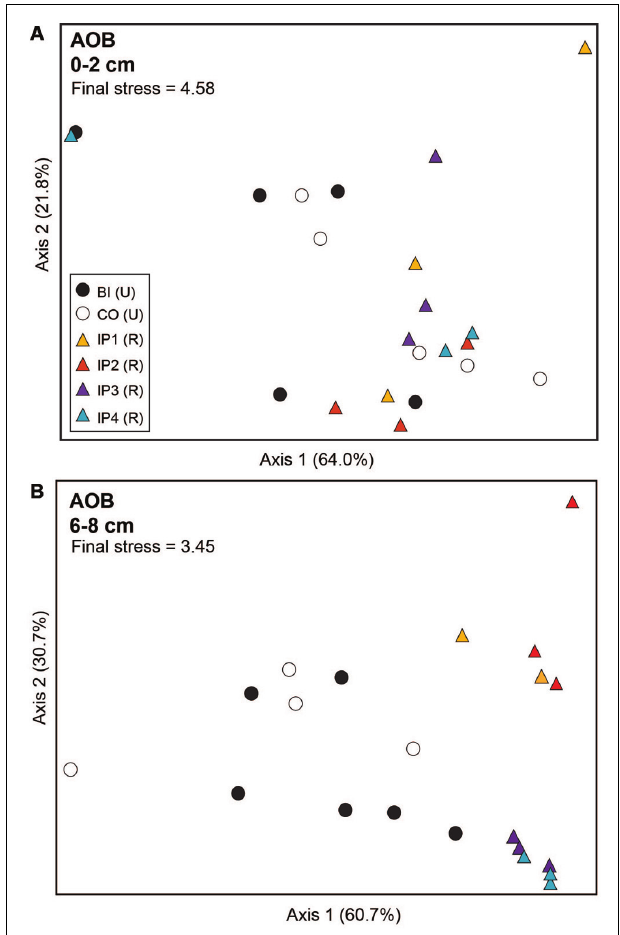
FIGURE 4 | Non-metric multidimensional scaling plot ofTRFLP profiles for betaproteobacterial amo A genes in surface (A) and deep (B) sediments. Percent variability explained by each axis is shown parenthetically on the axis labels. In both panels, triangles represent restored (R) marshes (IP 1–4); cirlces represent undisturbed (U) marshes from Barn Island (BI) or Cottrell (CO) marshes.